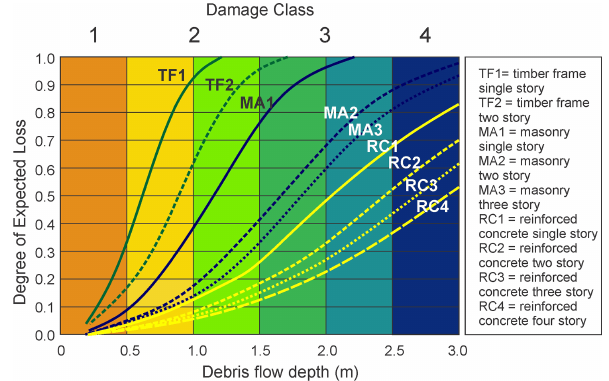
Figure 21. Vulnerability identified by degree of expected loss for constructed buildings by debris flow depth (Ciurean et al.,